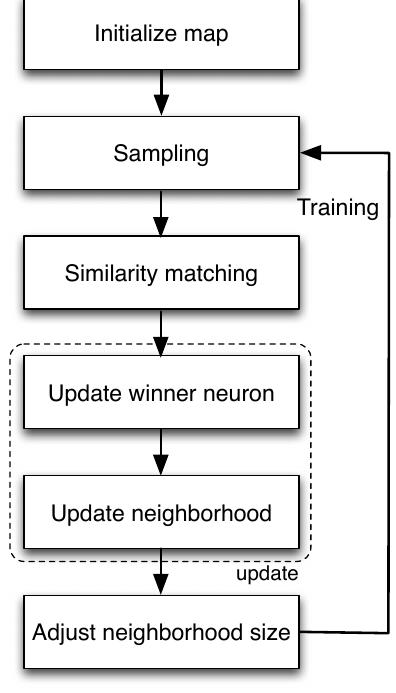
Figure 6. Flow diagram of the SOM training